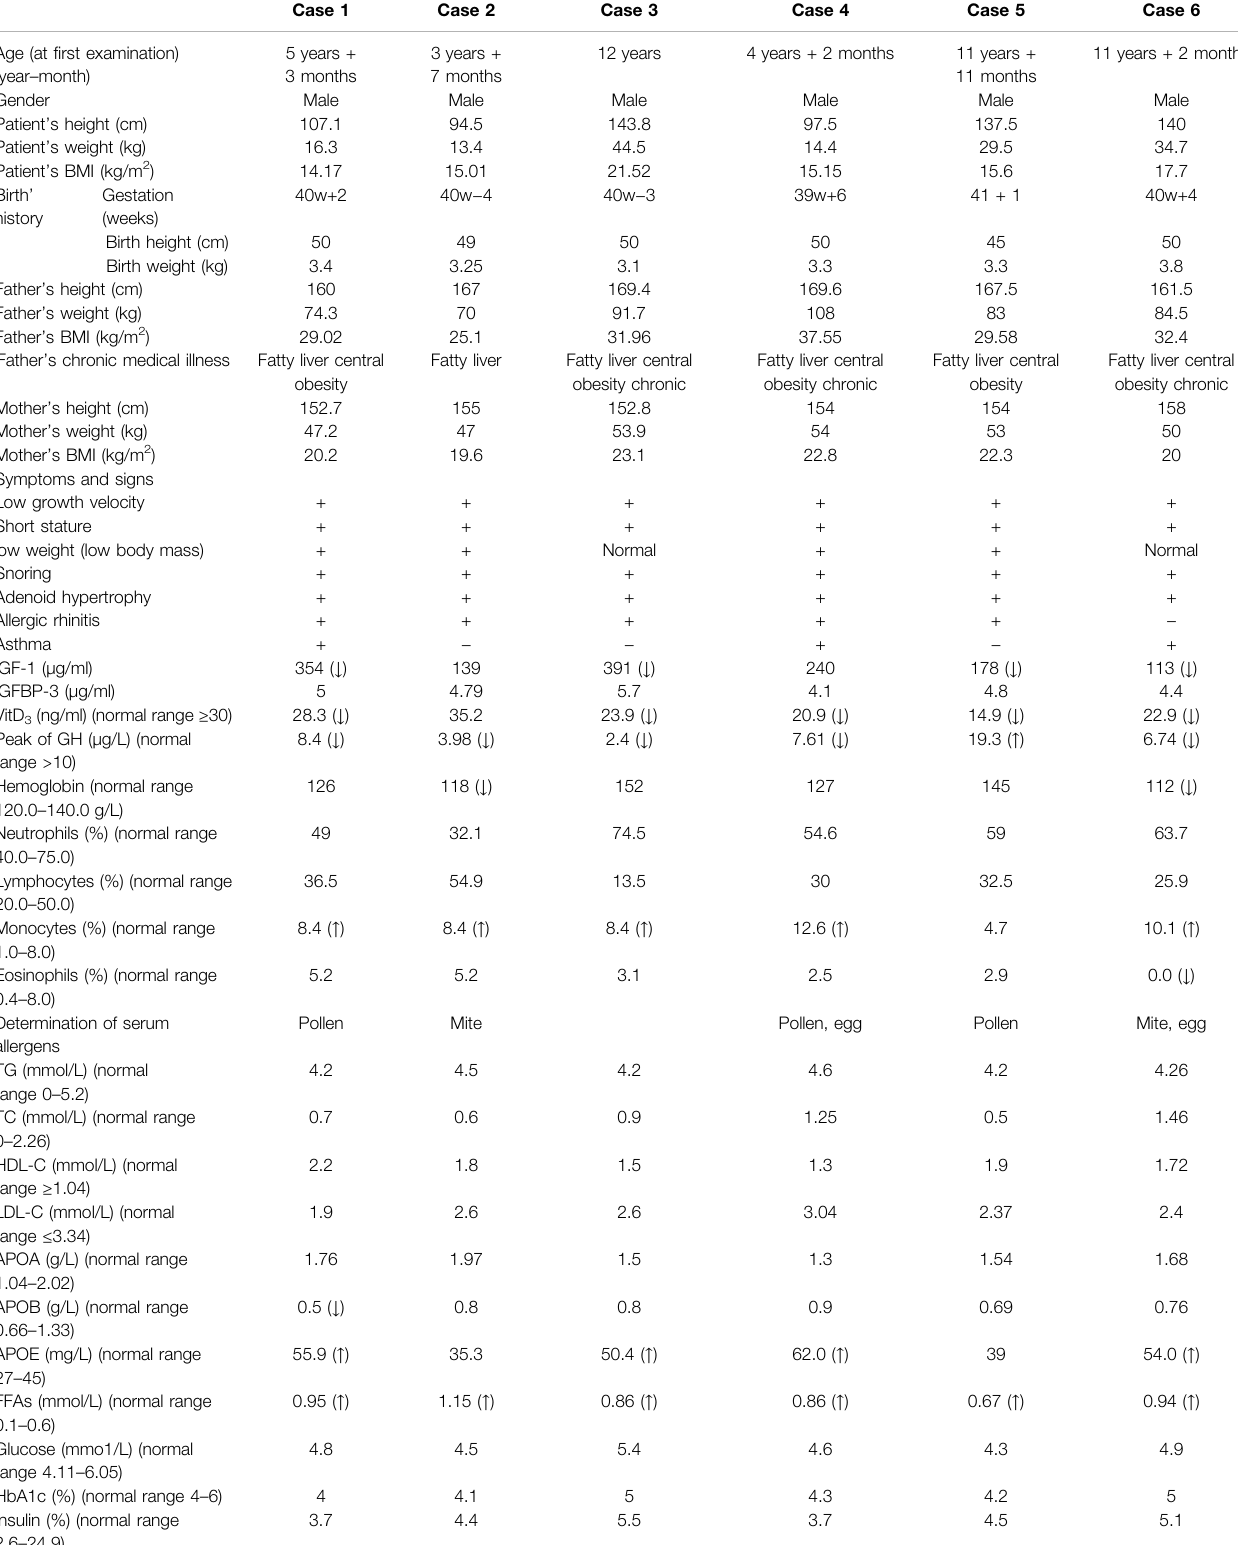
TABLE 1 | Summary of main clinical features and laboratory results of six cases with SLC22A18-associated